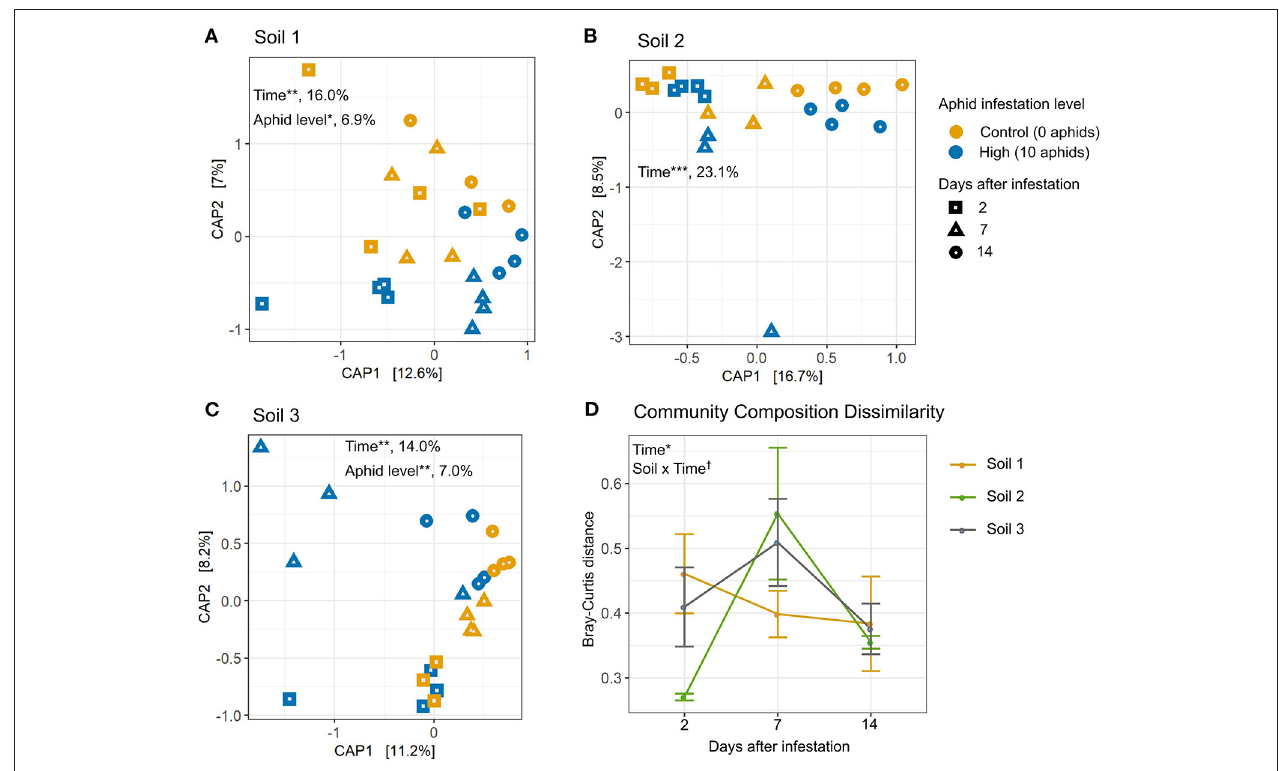
FIGURE 4 | Top-down effects of aphid herbivory alter rhizosphere bacterial community composition in two soils, and impacts vary over time and soil type. Canonical analysis of principle component (CAP) plots showing Bray-Curtis distance between sample community compositions in (A) Soil 1, (B) Soil 2, and (C) Soil 3. Bray-Curtis distance represents variation among samples due to both taxa presence and relative abundance. Points on plots represent individual samples. Color represents aphid infestation level and shape represents the number of days after infestation. Percent variance explained is listed after significant CAP factors. Distance between aphid-infested and control samples within each block were plotted over time for (D) Bray-Curtis distance. Statistically different factors (* p < 0.05, ** p < 0.01, *** p < 0.001, † p < 0.1) are labeled on the panel to which they